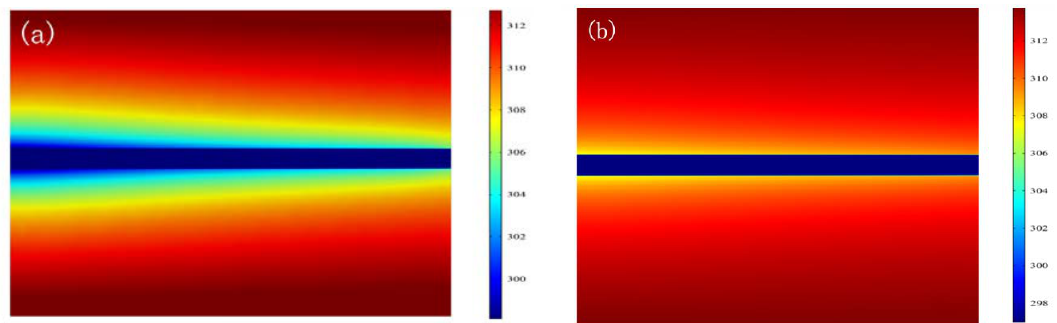
Figure 8. Comparison chart of thermal insulation effect of supporting materials (cross section): ( a ) cloud diagram of the temperature field of the concrete support roadway; ( b ) cloud diagram of the temperature field of the roadway supported by the test specimen XX45 insulation material.